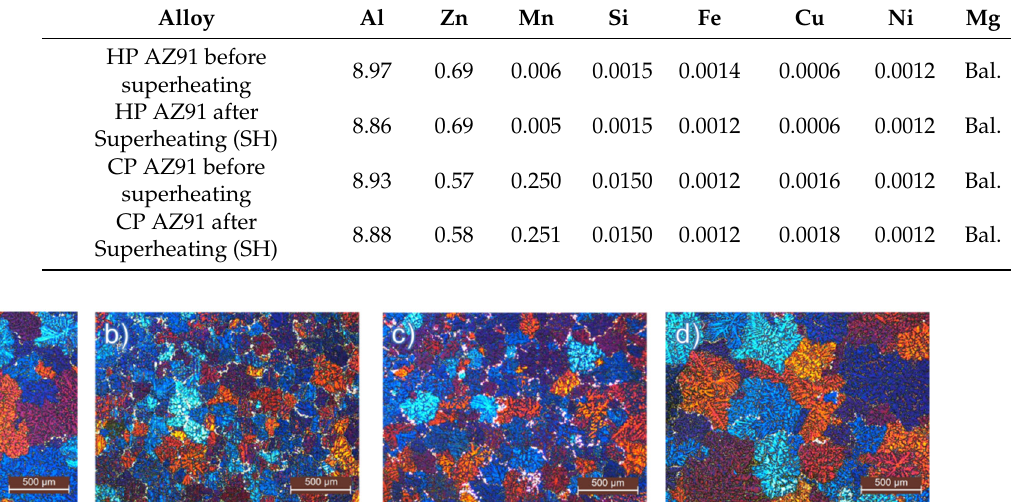
Table 2. Chemical compositions of high-purity (HP) and commercial-purity (CP) AZ91 Mg alloys before and after superheating (SH).